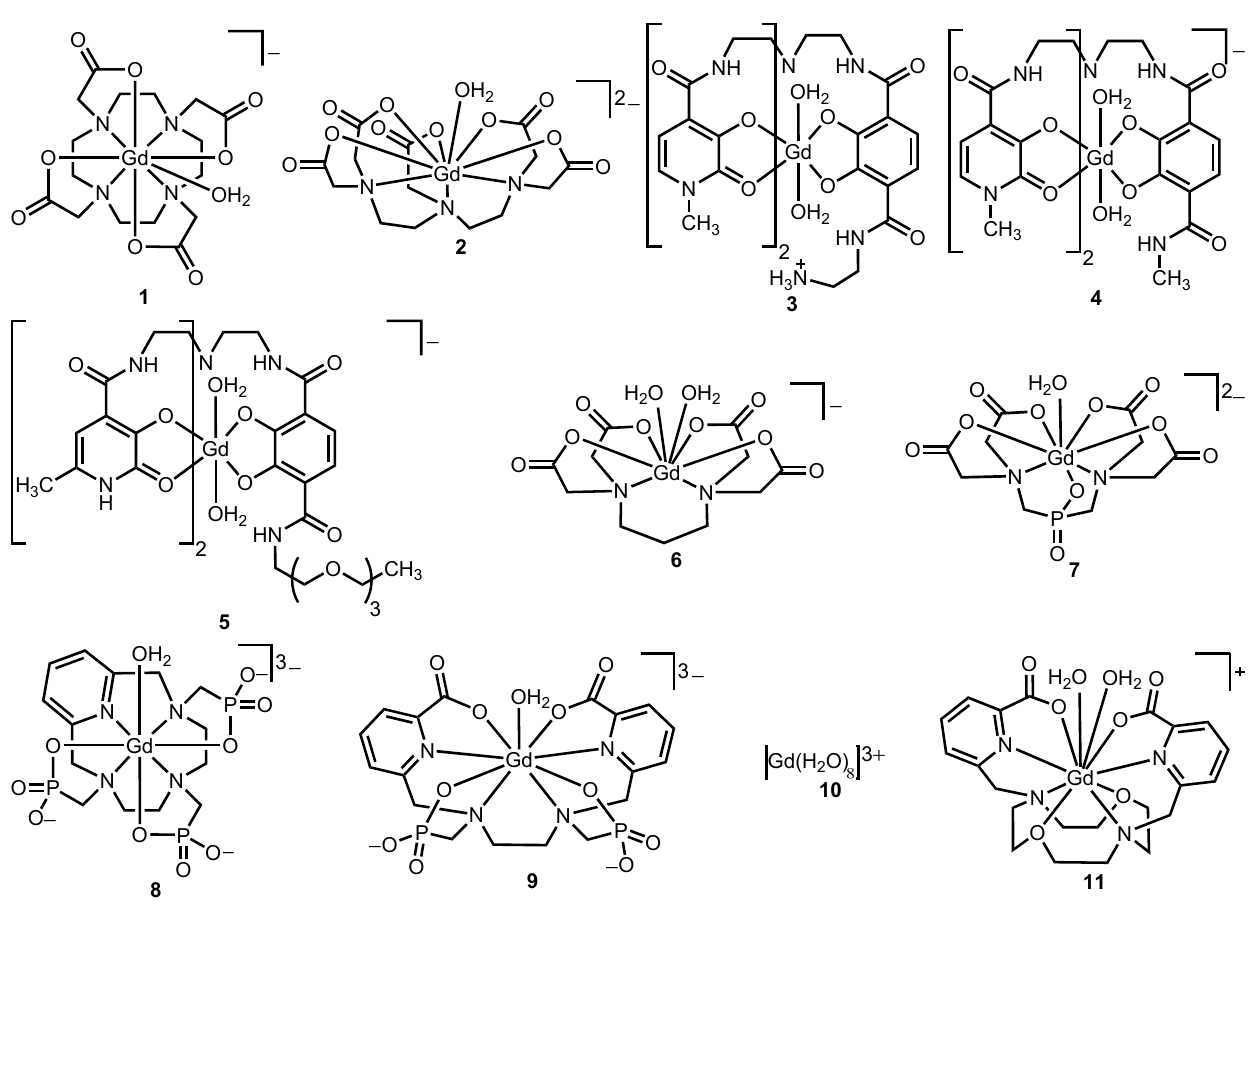
Figure 2. Representative Gd III -containing complexes that undergo water exchange via dissociative ( 1 and 2 ), dissociative interchange ( 9 ), associative ( 3 , 4 , 7 , 8 , 10 , and 11 ), and associative interchange ( 5 and 6 ) processes